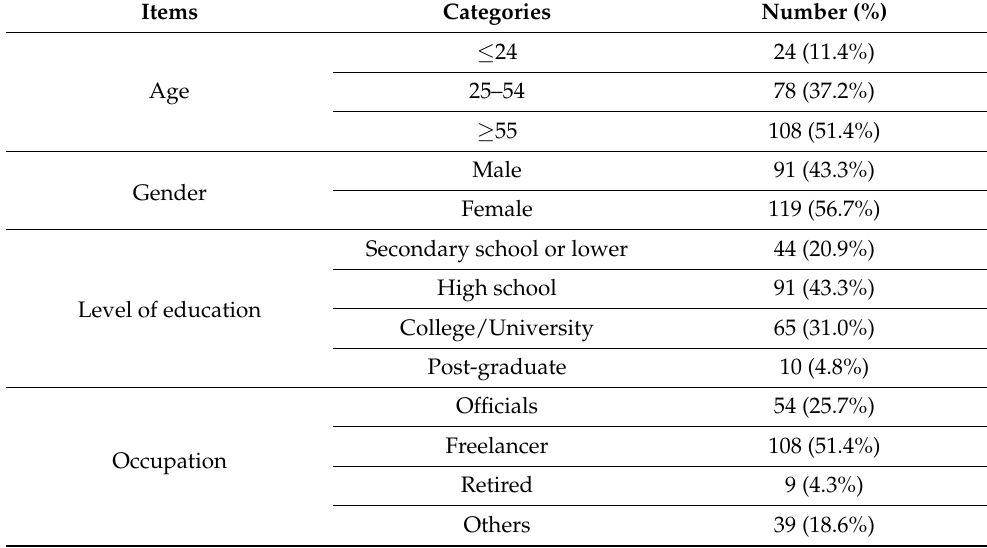
Table 2. Characteristics of the